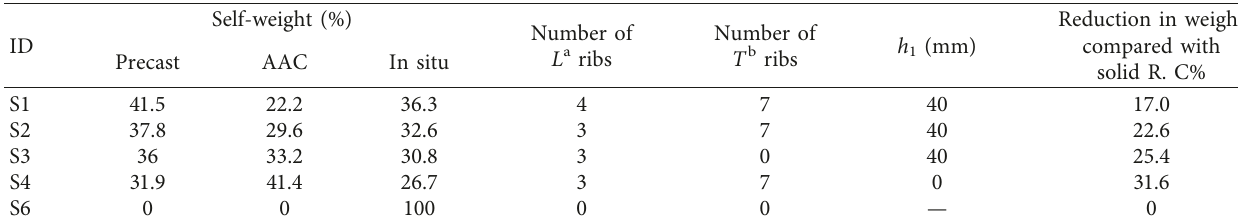
Figure 3: Brick layout and cross-sectional details of the specimens: (a) S1 brick layout and A-A cross-sectional details, (b) S2 brick layout and A-A cross-sectional details, (c) S3 brick layout and A-A cross-sectional details, (d) S4 brick layout and A-A cross-sectional details, and (e) S6 layout and A-A cross-sectional details. Table 1: Characteristics of all